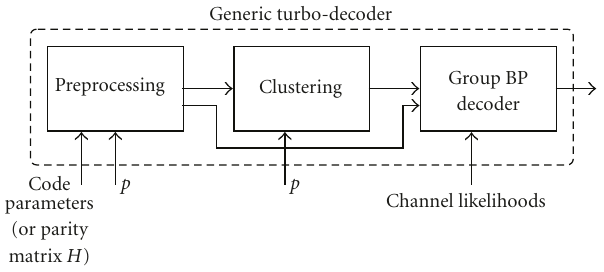
Figure 1: Block representation of the generic turbo decoder based on group BP